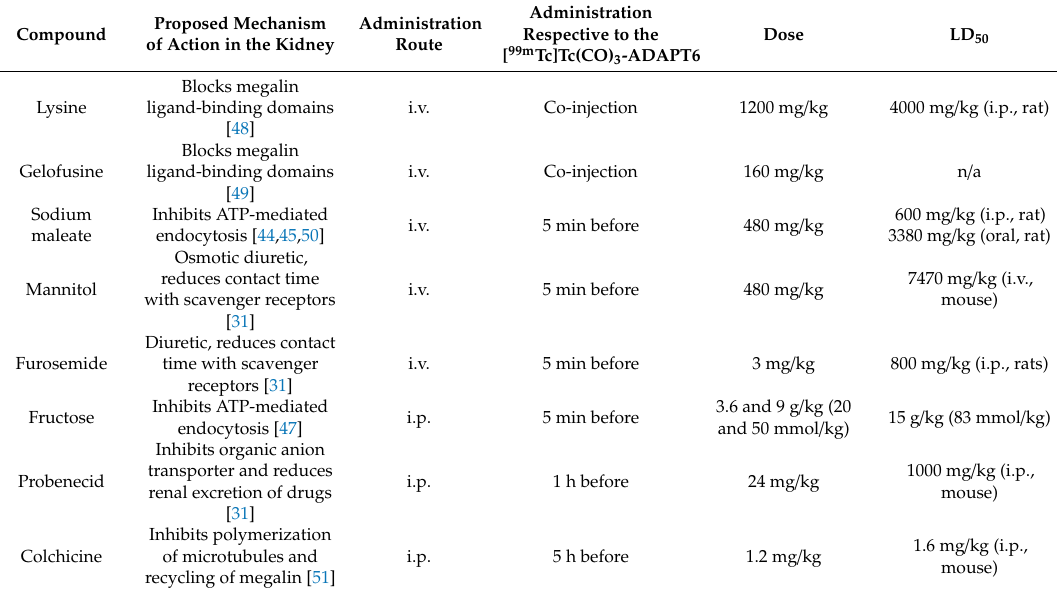
Table 2. List of compounds, their proposed mechanism of action and administration protocol preceding the injection of [ 99m Tc]Tc(CO) 3